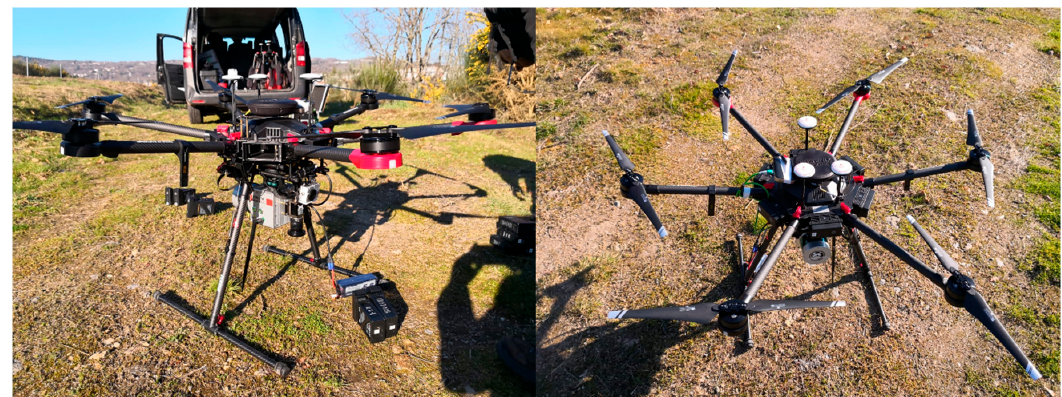
Figure 2. Aerial Light Detection and Ranging (LiDAR) system used for the survey.